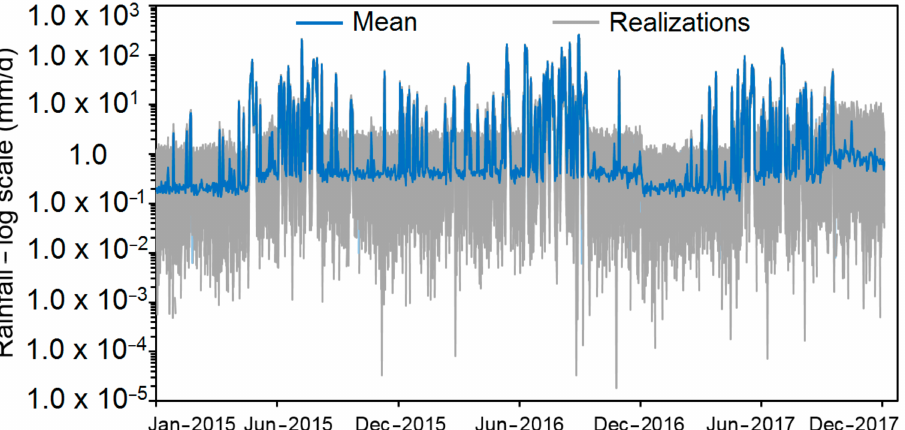
Figure 5. An example of the mean and the random precipitation fluctuations at a station in the sub-model for the GSFLOW simulations. In the study, there are 100 realizations used for the Monte Carlo